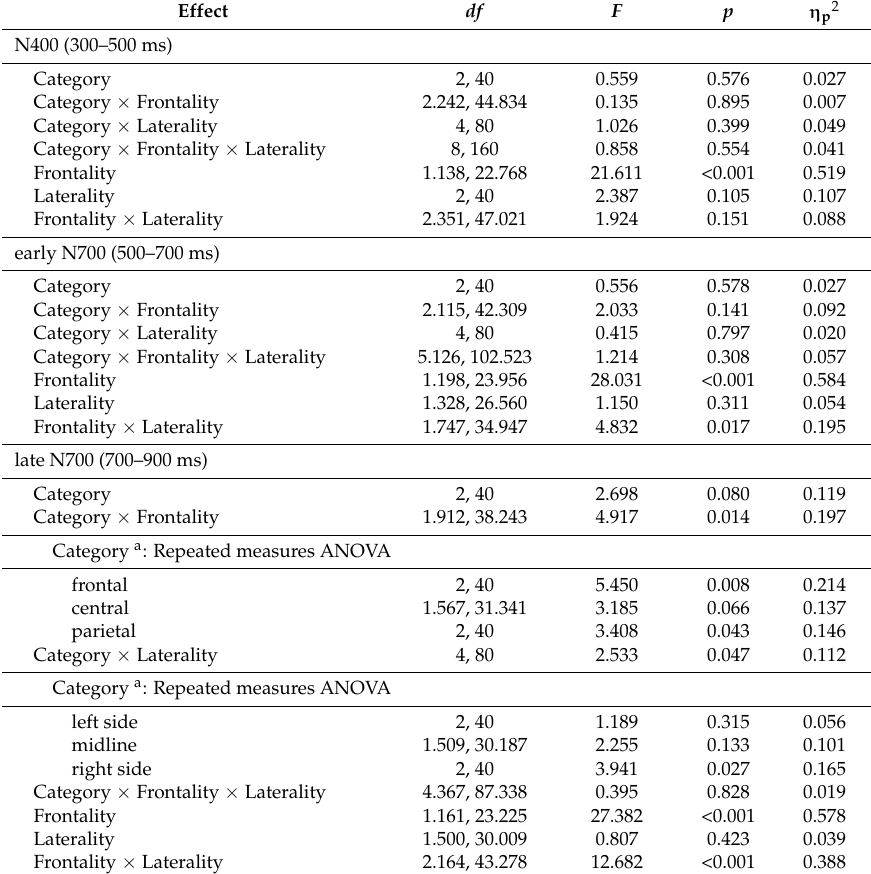
Table 2. Novel word analyses. Full inferential statistics of the 3 × 3 × 3 repeated measures ANOVA on N400, early N700 and late N700 amplitudes as well as repeated measures ANOVAs with the factor Category (OPic, SPic, NoPic) resolving the significant